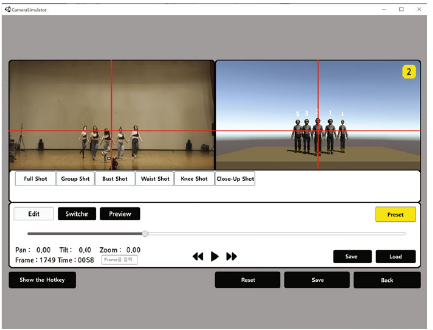
Figure 5: Camera and switcher plan authoring simulator to which rehearsal video and acquired movement data were applied on the virtual